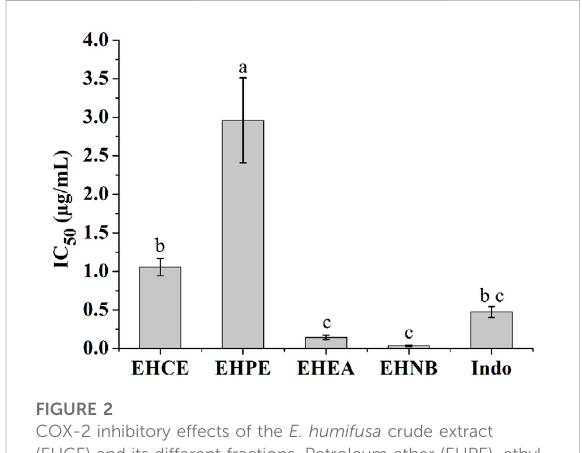
FIGURE 2 COX-2 inhibitory effects of the E. humifusa crude extract (EHCE) and its different fractions. Petroleum ether (EHPE), ethyl- acetate (EHEA) and n- butanol (EHNB). The label letters (a − c) represent the signi fi cant difference at p -value < 0.05 by ANOVA